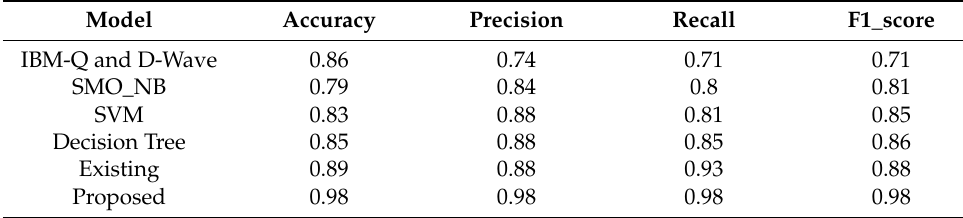
Table 8. Comparative assessment with the classification techniques [44].